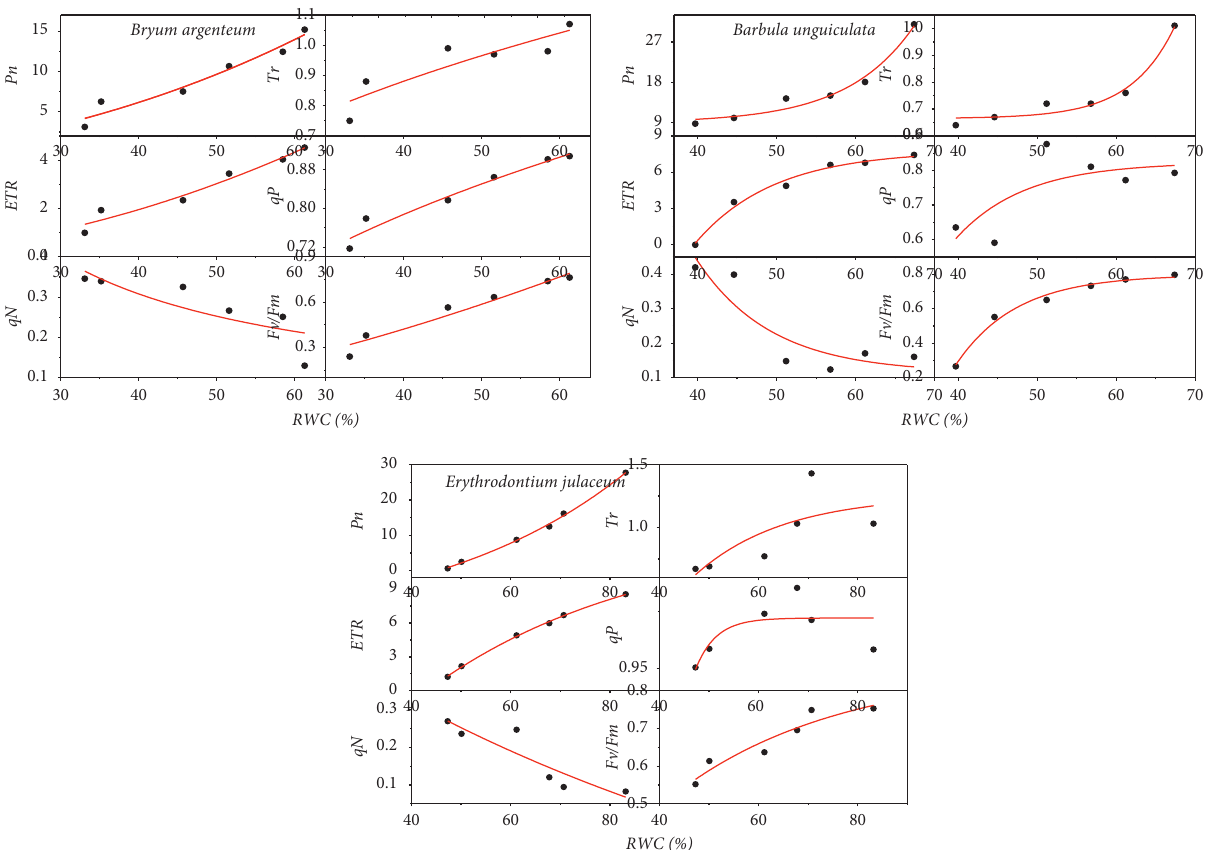
Figure 3: Relationship between photosynthesis indexes and RWC in three epilithic mosses during dehydration. Erythrodontium julaceum (Schwaegr.) Par. with permission from